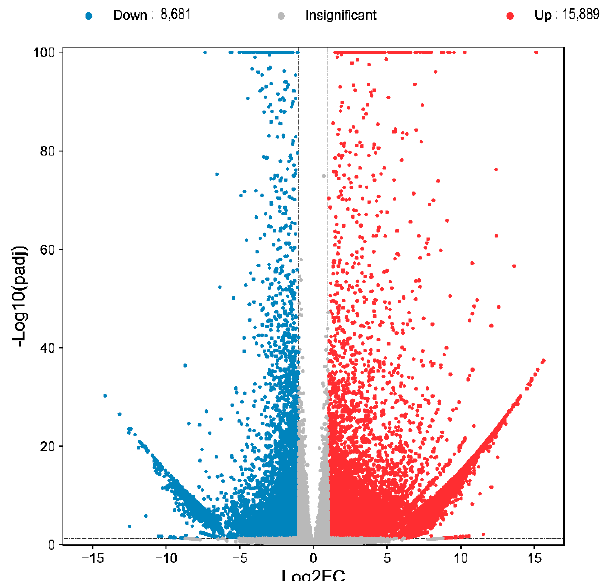
Figure 4. Volcano plot of DEGs in TH vs. TL. The abscissa represented log 2 (fold change), and the ordinate represented − log 10 (adjusted p -value). Red dots were the up-regulated DEGs, blue dots were the down-regulated DEGs. Gray dots were genes of nonsignificant difference.